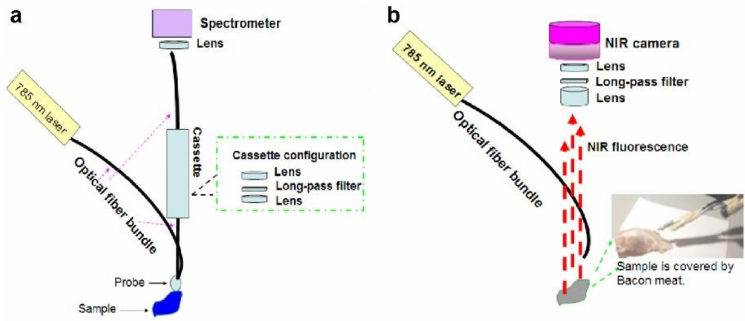
Figure 1. ( a ) Schematic for measurement of NIR fluorescence. ( b ) Schematic for NIR tissue